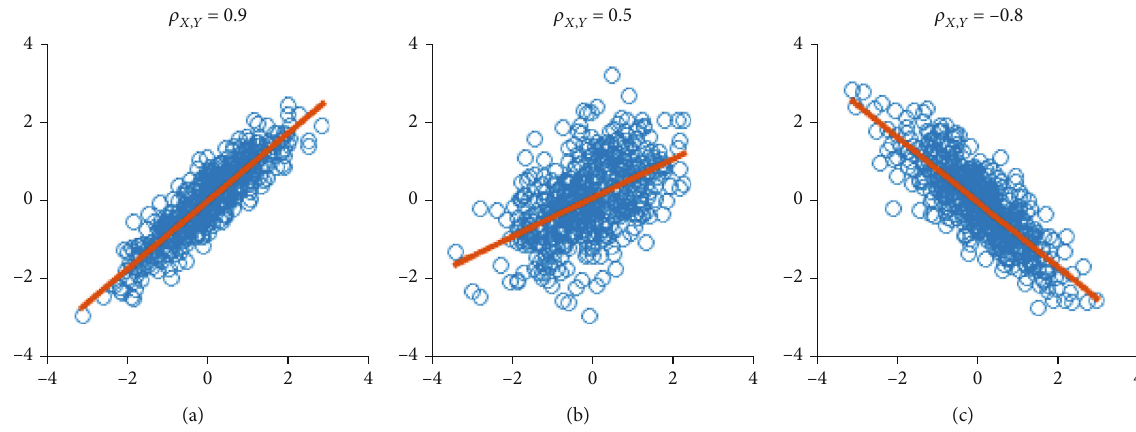
Figure 10: Single correlation line or coe ffi cient for several types of data; ρ = 0 : 9 , 0.5, and − 0.8.